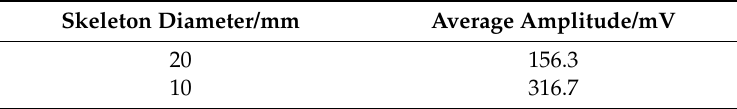
Table 4. Average amplitude of broken lead signal detected by FOR AE